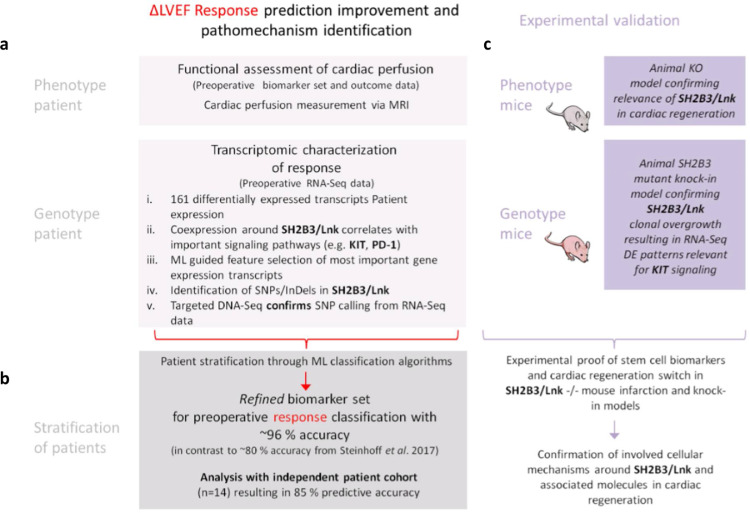
Overview of utilized integrative analysis approach integrating clinical patient data with murine pre-clinical models: Genotype/phenotype analysis in randomised clinical trial PERFECT cardiac regeneration outcome and knock-out animal disease model verification of regulatory genes.